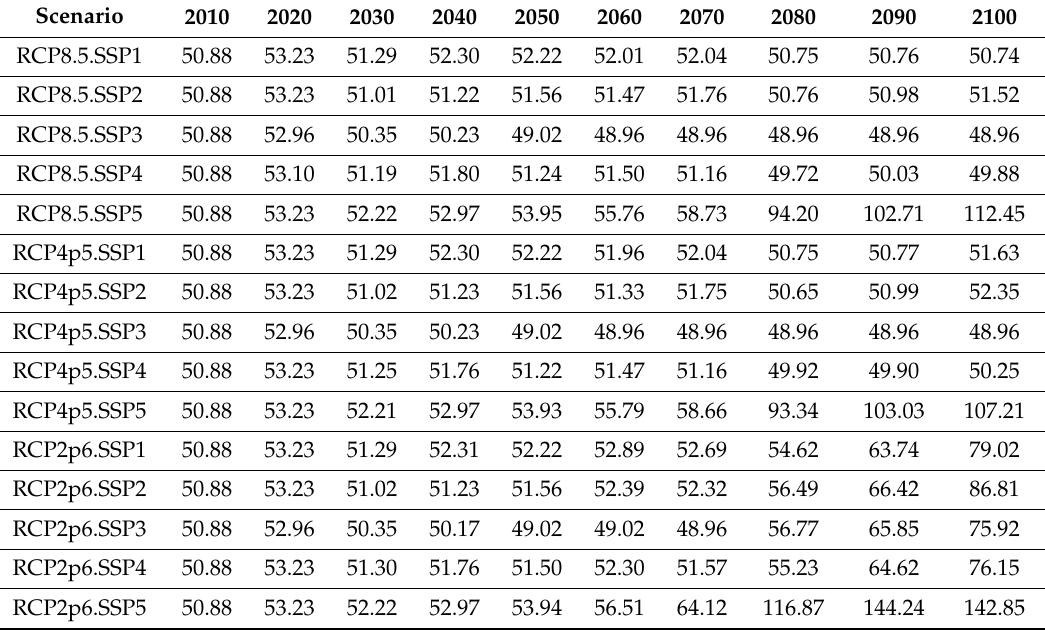
Table A13. Prices—Pulpwood (National average price per m 3 , in USD (exchange rate in 2010)).